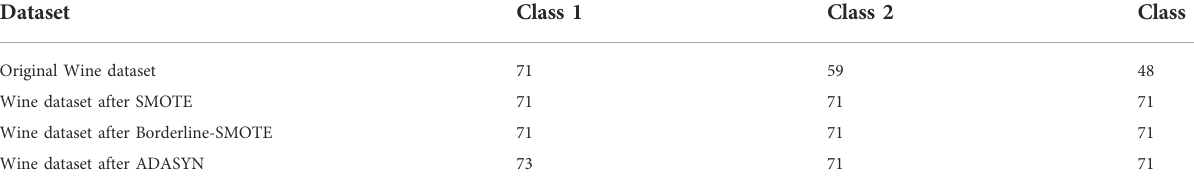
TABLE 7 Details of the Wine dataset and the dataset after the class balance methods processing.